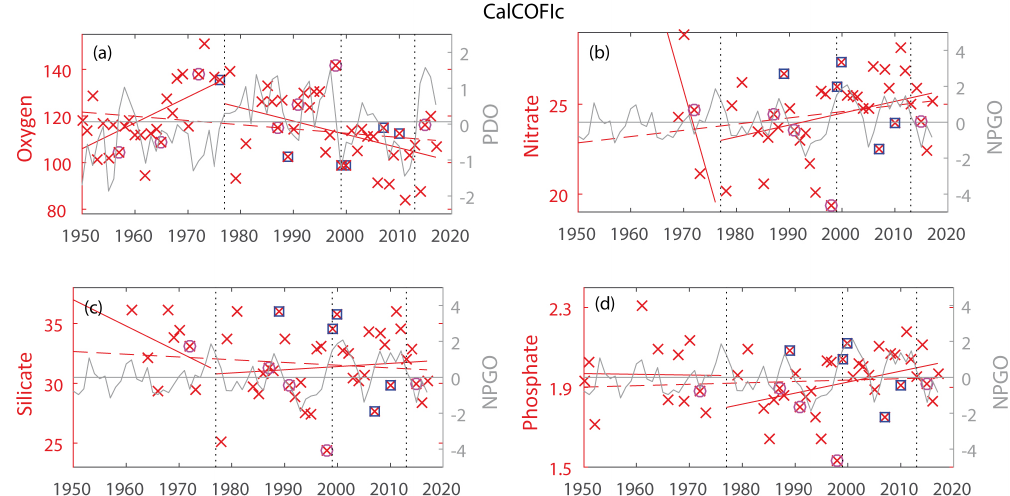
Figure 5. Annual mean concentration (µmolkg − 1 , red crosses) for years available and trends for the layer from 50 to 300m plotted for the entire time period (dashed red lines) and for the periods 1950 to 1976 for the negative PDO phase and after 1976 for the positive PDO phase (solid red lines) between 34 and 35 ◦ N, 121 and 122 ◦ W from the CalCOFIc bottle data in micromoles per kilogram per year for (a) oxygen, (b) nitrate, (c) silicate and (d) phosphate. El Niño years defined as strong and very strong are marked by an additional magenta circle and strong La Niña years by an additional blue square. The changes of the PDO status in 1977, 1999 and 2013 are marked by vertical dotted lines. The annual mean PDO index is shown in the oxygen time series as a grey curve and the NPGO index is shown in the nitrate, silicate and phosphate time series as a grey